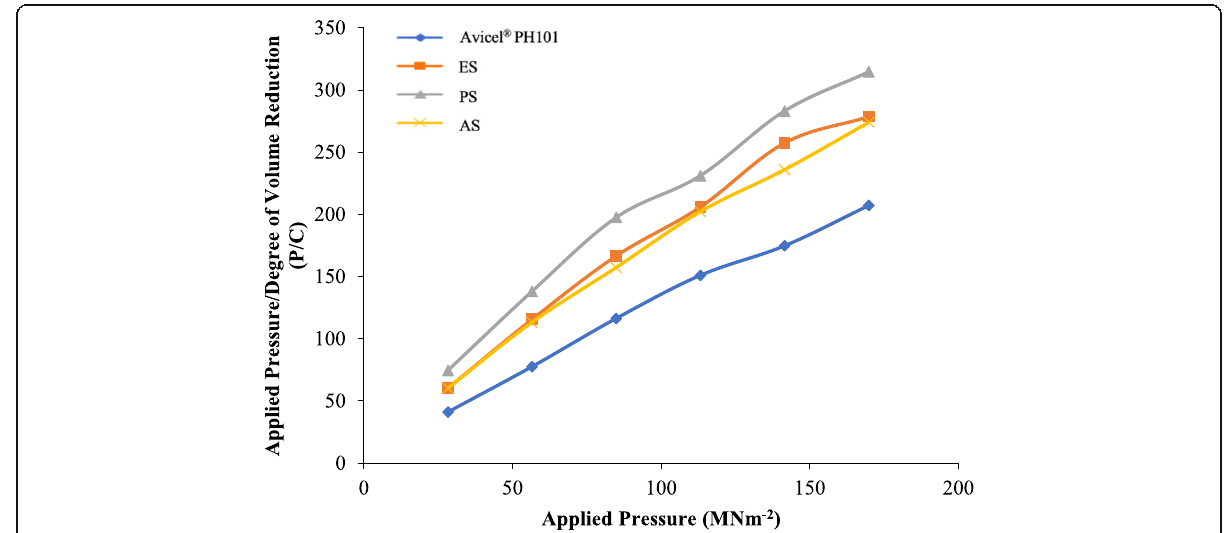
Fig. 1 Kawakita profiles for modified starches (ES, PS, AS) and Avicel® PH101 of compact excipients